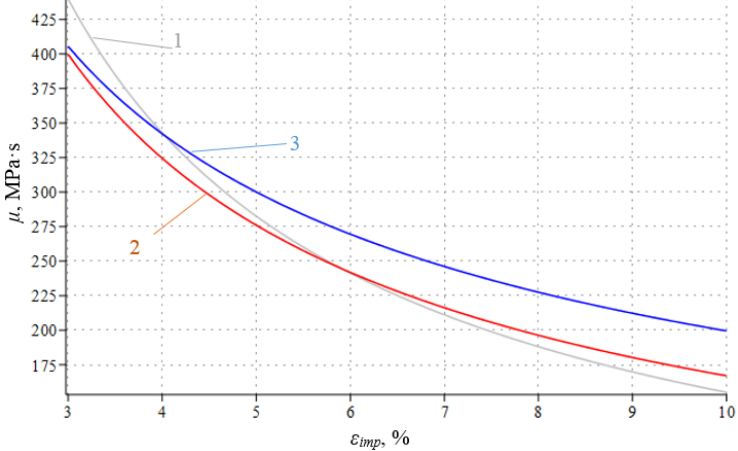
Figure 12. Approximated effective shear viscosity μ versus ε imp dependences for aluminum alloys: 1 — alloy 2024-T351; 2 — alloy D16ChATW; 3 — alloy T. The corresponding data approximations are shown in Figure 12 below: